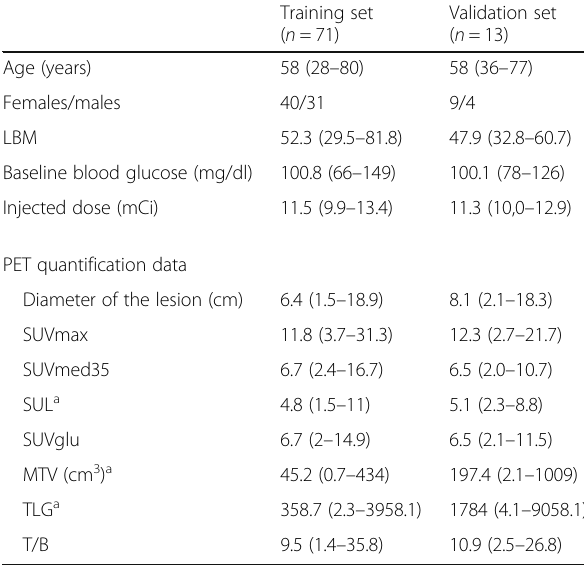
Table 1 Demographics and quantification data in the training and validation sets ; mean and range values are